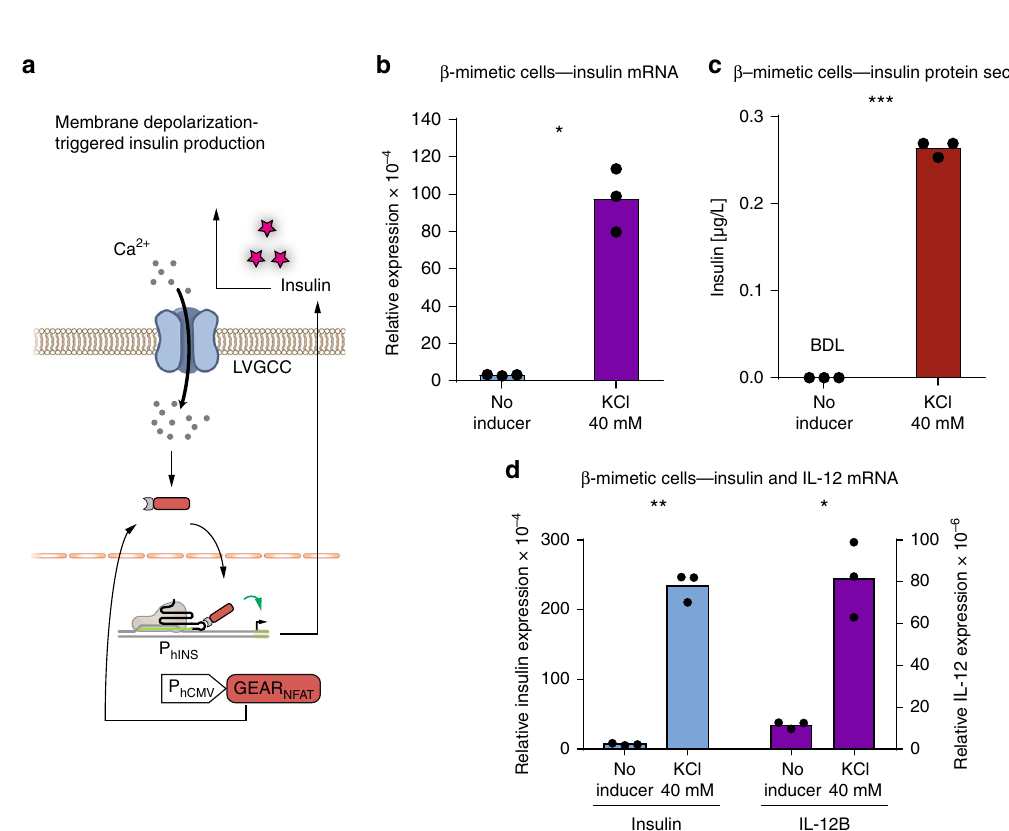
Fig. 3 Rewiring intracellular calcium signaling to genomic targets. a Membrane depolarization-triggered insulin expression. Cell membrane depolarization causes calcium in fl ux via L-type voltage-gated calcium channels, followed by nuclear translocation of GEAR NFAT, and endogenous insulin promoter (P hINS ) activation. b, c 24 h after the beginning of transfection, β -mimetic cells expressing dCas9, GEAR NFAT , and a human insulin promoter- speci fi c sgRNA were depolarized with 40 mM KCl. Insulin mRNA b and protein in the supernatant c were quanti fi ed after 36 h. d GEAR NFAT -driven multiple gene activation. β -Mimetic cells expressing dCas9, L-type voltage-gated calcium channel, GEAR NFAT and P hINS -speci fi c sgRNA, as well as P hIL-12B -speci fi c sgRNA were depolarized with 40 mM KCl. Insulin and IL-12B mRNA levels were quanti fi ed after 36 h. Blue bars and the left axis correspond to insulin mRNA. Violet bars and the right axis correspond to IL-12B mRNA. Black dots correspond to individual data points of n = 3 biologically independent samples. BDL below detection limit, ns nonsigni fi cant, * p < 0.05, ** p < 0.01, *** p < 0.001. Statistical signi fi cance was calculated using a two-tailed t -test. A detailed description of the statistical analysis is provided in Supplementary Table 5. Source data are provided as a Source Data fi